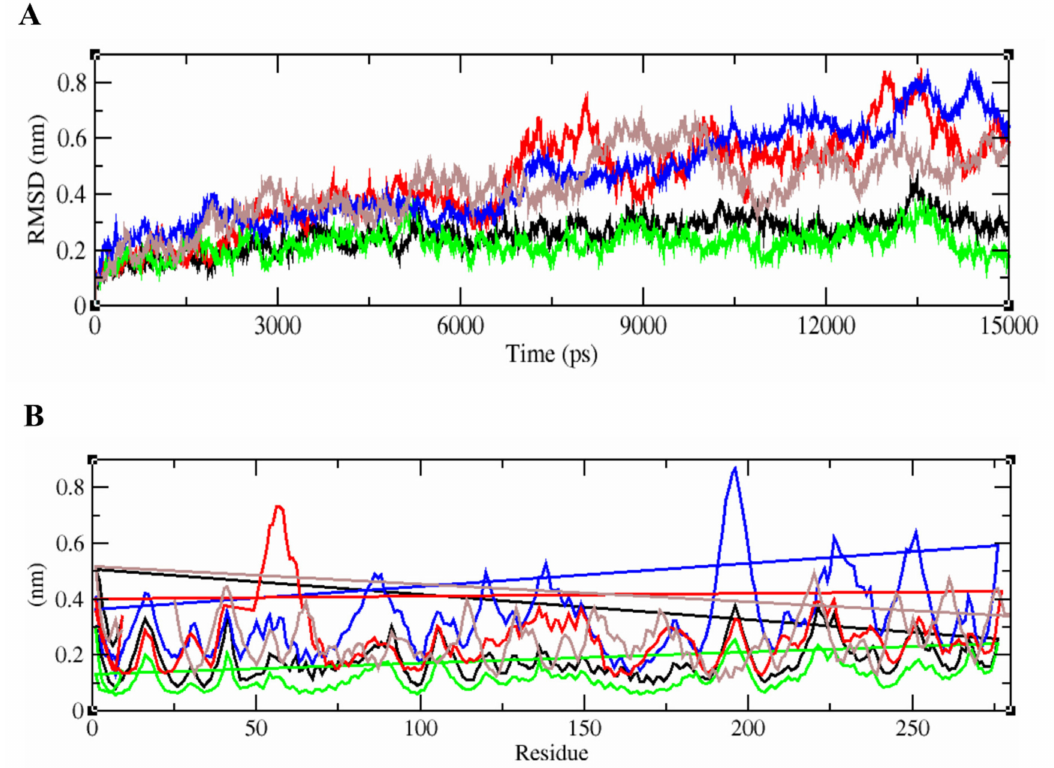
Figure 5. RMSD and RMSF plots generated for the epitope-HLA complexes of Wuhan, England, USA, Indian, and South African variants. ( A ) represents the unstable RMSD values of the complex from England, India, South Africa, USA, and the Wuhan isolates in green, black, brown, red, and blue respectively.The epitope/HLA combinations of England and Indian strains were found to be more stable than that of others. ( B ) represents the fluctuation patterns of the protein–peptide complexes of all five SARS-CoV-2 variants analyzed with their RMSF values given in nm. The amino acid residues of Wuhan strain displayed a maximum deviation in the fluctuation map up to 0.8